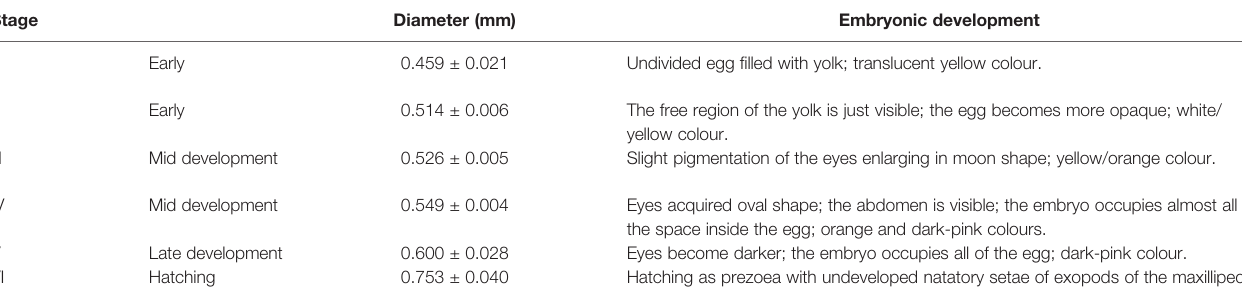
TABLE 3 | Description of the stages of embryonic development, and the respective maximum diameter (mm) of Segonzacia mesatlantica according to Arshad et al. (2006); Tuset et al. (2011) and Martínez-Rivera et al. (2020).